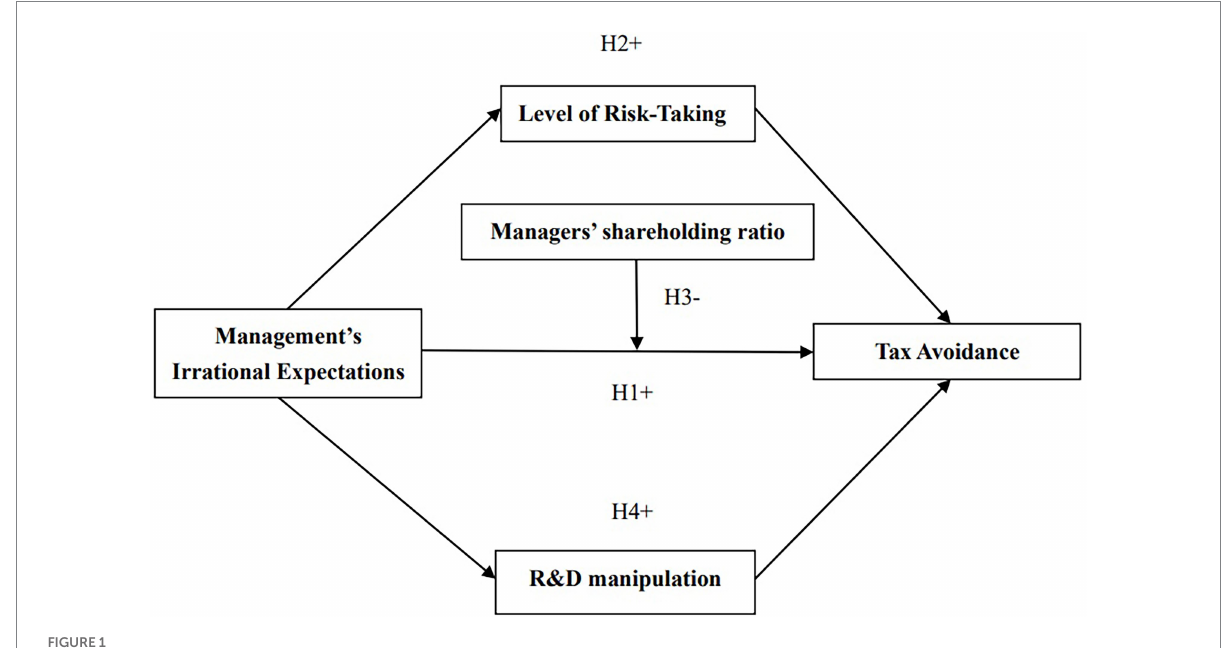
FIGURE 1 Conceptual